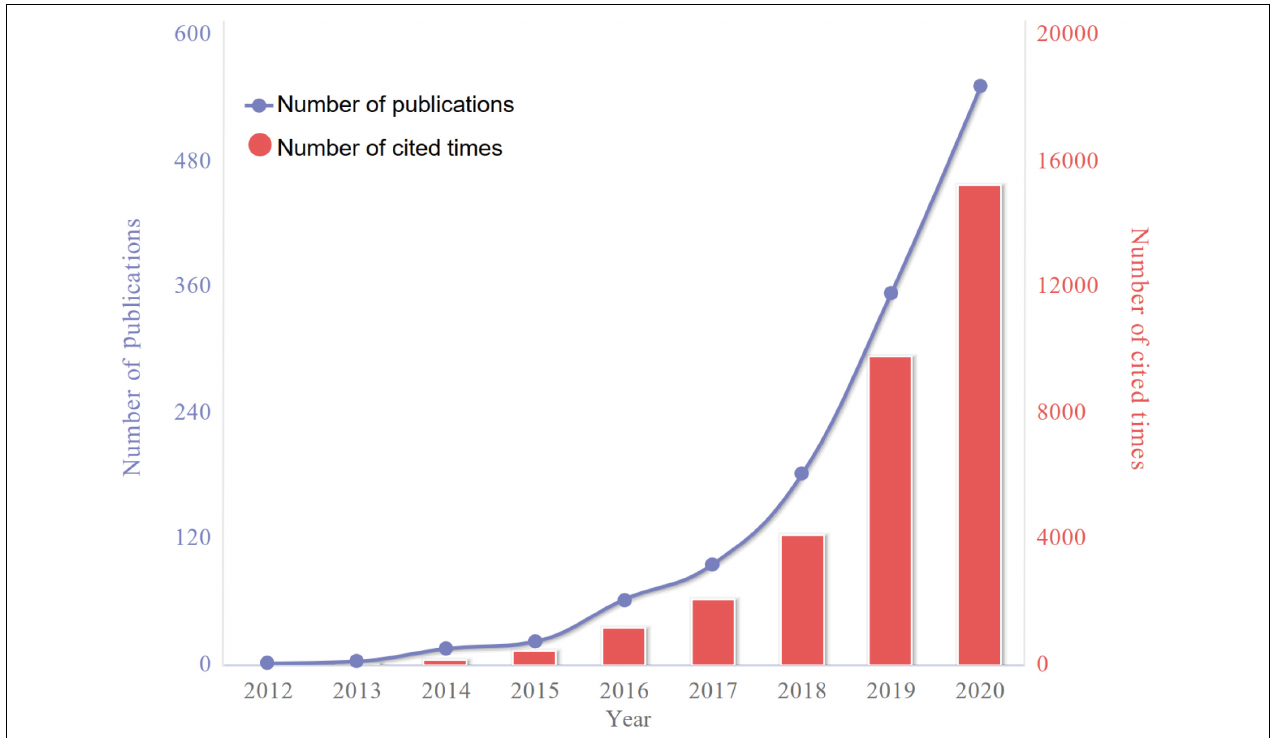
FIGURE 2 | The number of articles published annually and the summed total citations of annual articles related to ferroptosis have been steadily increasing from 2012 to